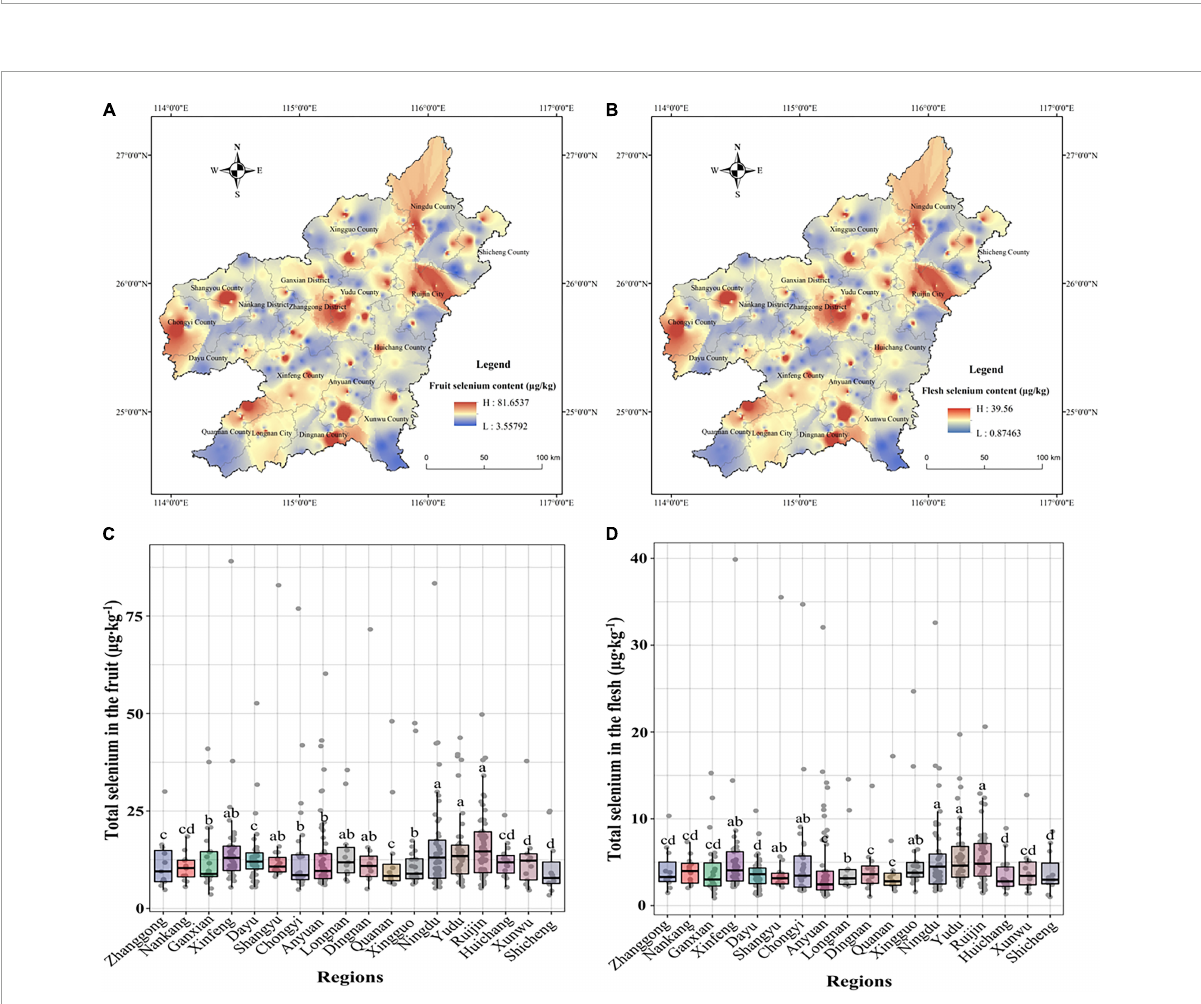
FIGURE3 Total Se content and spatial distribution in navel orange fruit (A,C) and flesh (B,D) in southern Jiangxi ( n = 492). Letters indicate a significant difference at p < 0.05 among